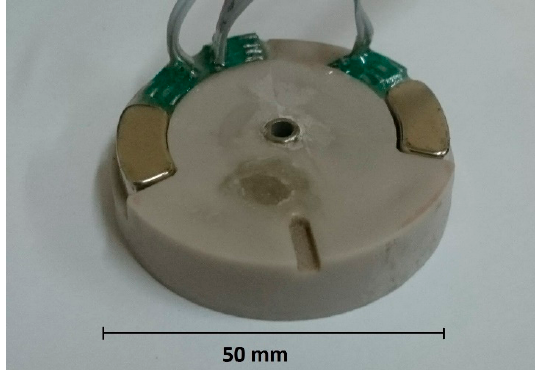
Figure 6. Photo of the molecular–electronic angular accelerometer with negative MHD feedback (without electronic plate).